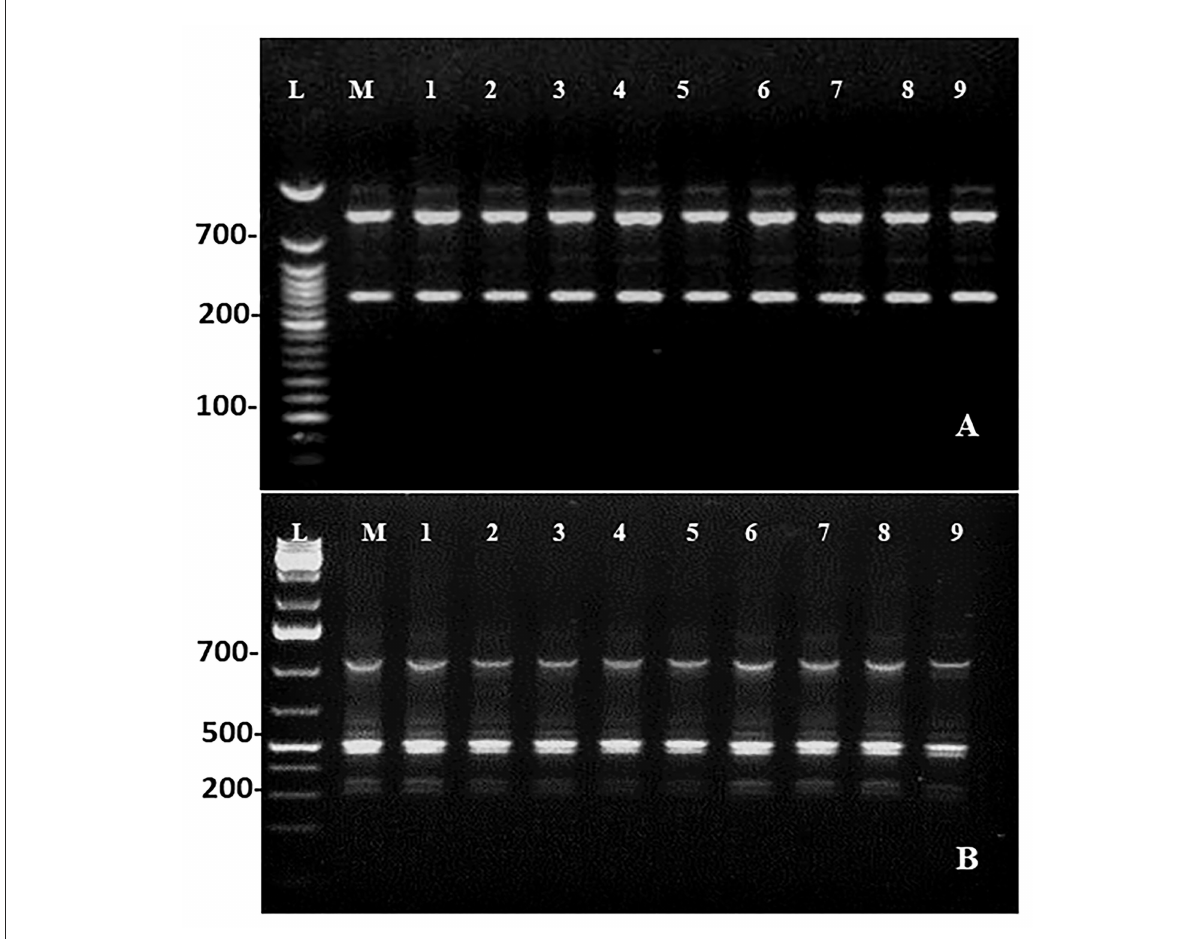
FIGURE5 DNA profiles of the mother (Lane M) with DNA ladder (lane L) and micropropagated plants (Lanes 1–9). (A) RAPD (OPU-08). (B) ISSR